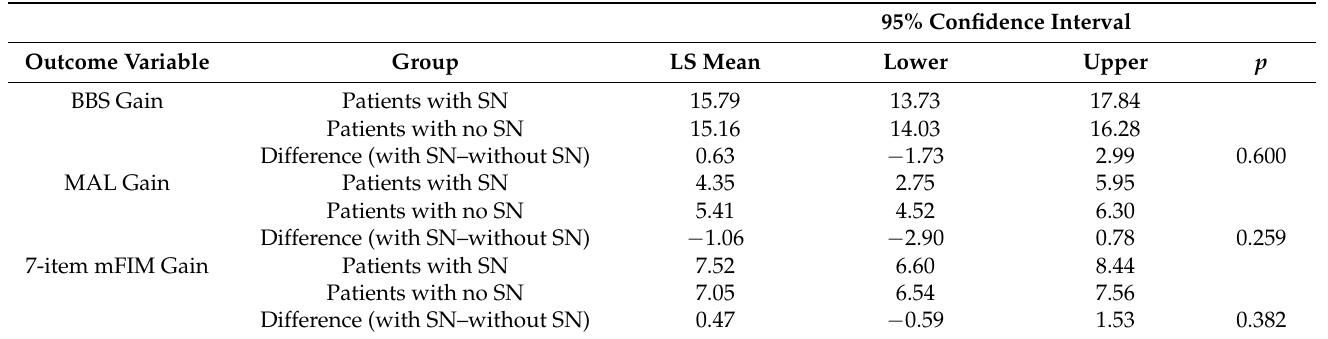
Table 4. Estimated least-squares means after the general linear modeling for different patient groups